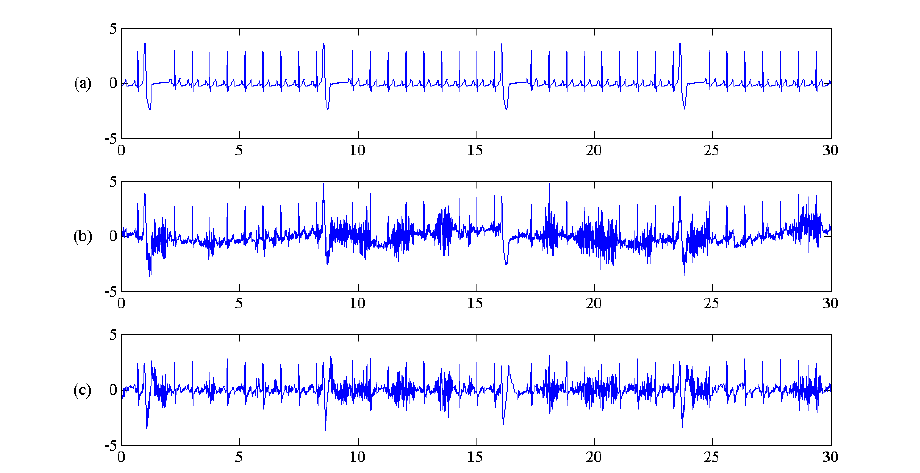
Figure 10. From top to bottom are (a) ventricular arrhythmia ECG (V1), (b) with muscle artifact ’ma’ noise and corresponding filter output by (c) IIR, (d) Wiener, (e) EMD and (f)